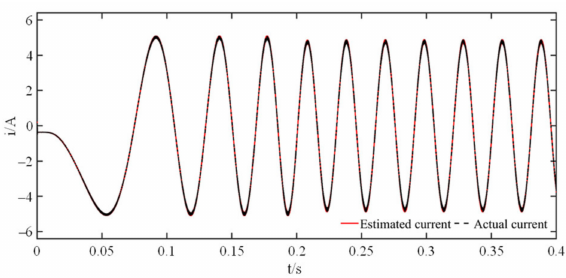
Figure 19. R = 0.102 Ω